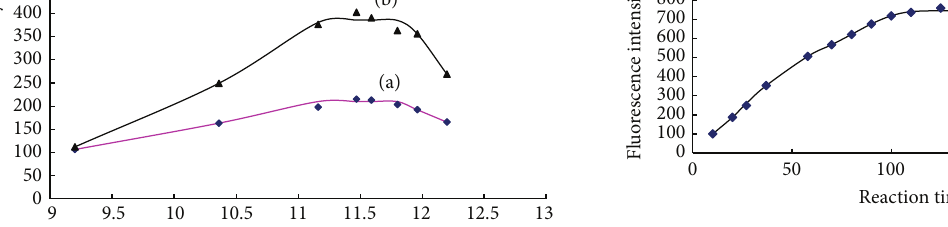
Figure 9: The relationship between fluorescence intensity and reac- tion